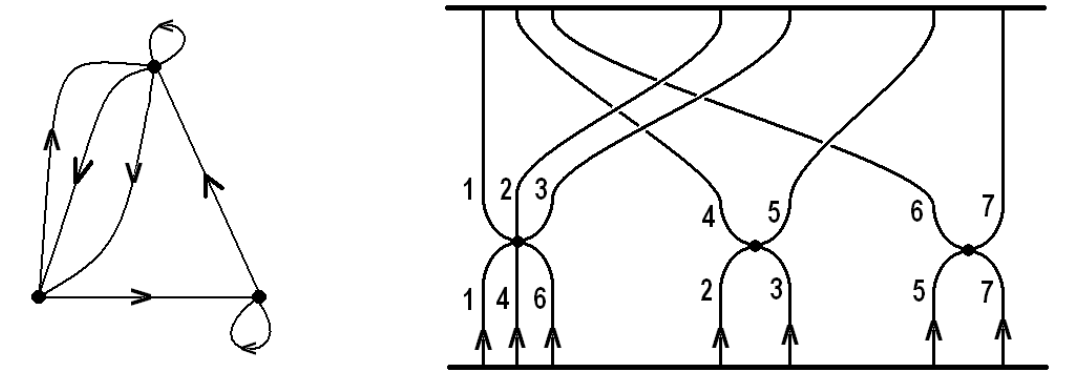
Figure 2 . Any open string configuration can be mapped to a labelled graph as shown. The two bold horizontal lines in the figure on the right are identified. Rows of R form nodes in the graph. For the graph shown, R has three rows. There are 7 open strings, so the operator is constructed using 7 Y fields. The graph determines a permutation, so each open string configuration maps to a permutation. For the graph shown the permutation, in cycle notation, is σ = (24)(536) . A nice example is the configuration in which all open strings loop back to the brane they start from, described by the identity